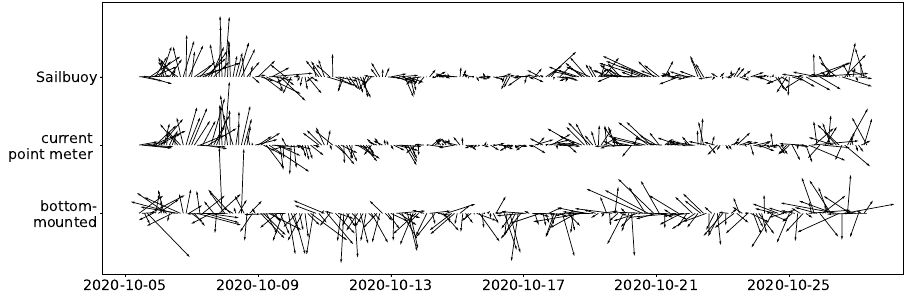
Figure 4. Current speed and direction measured by all three instruments at ca. 20m depth over